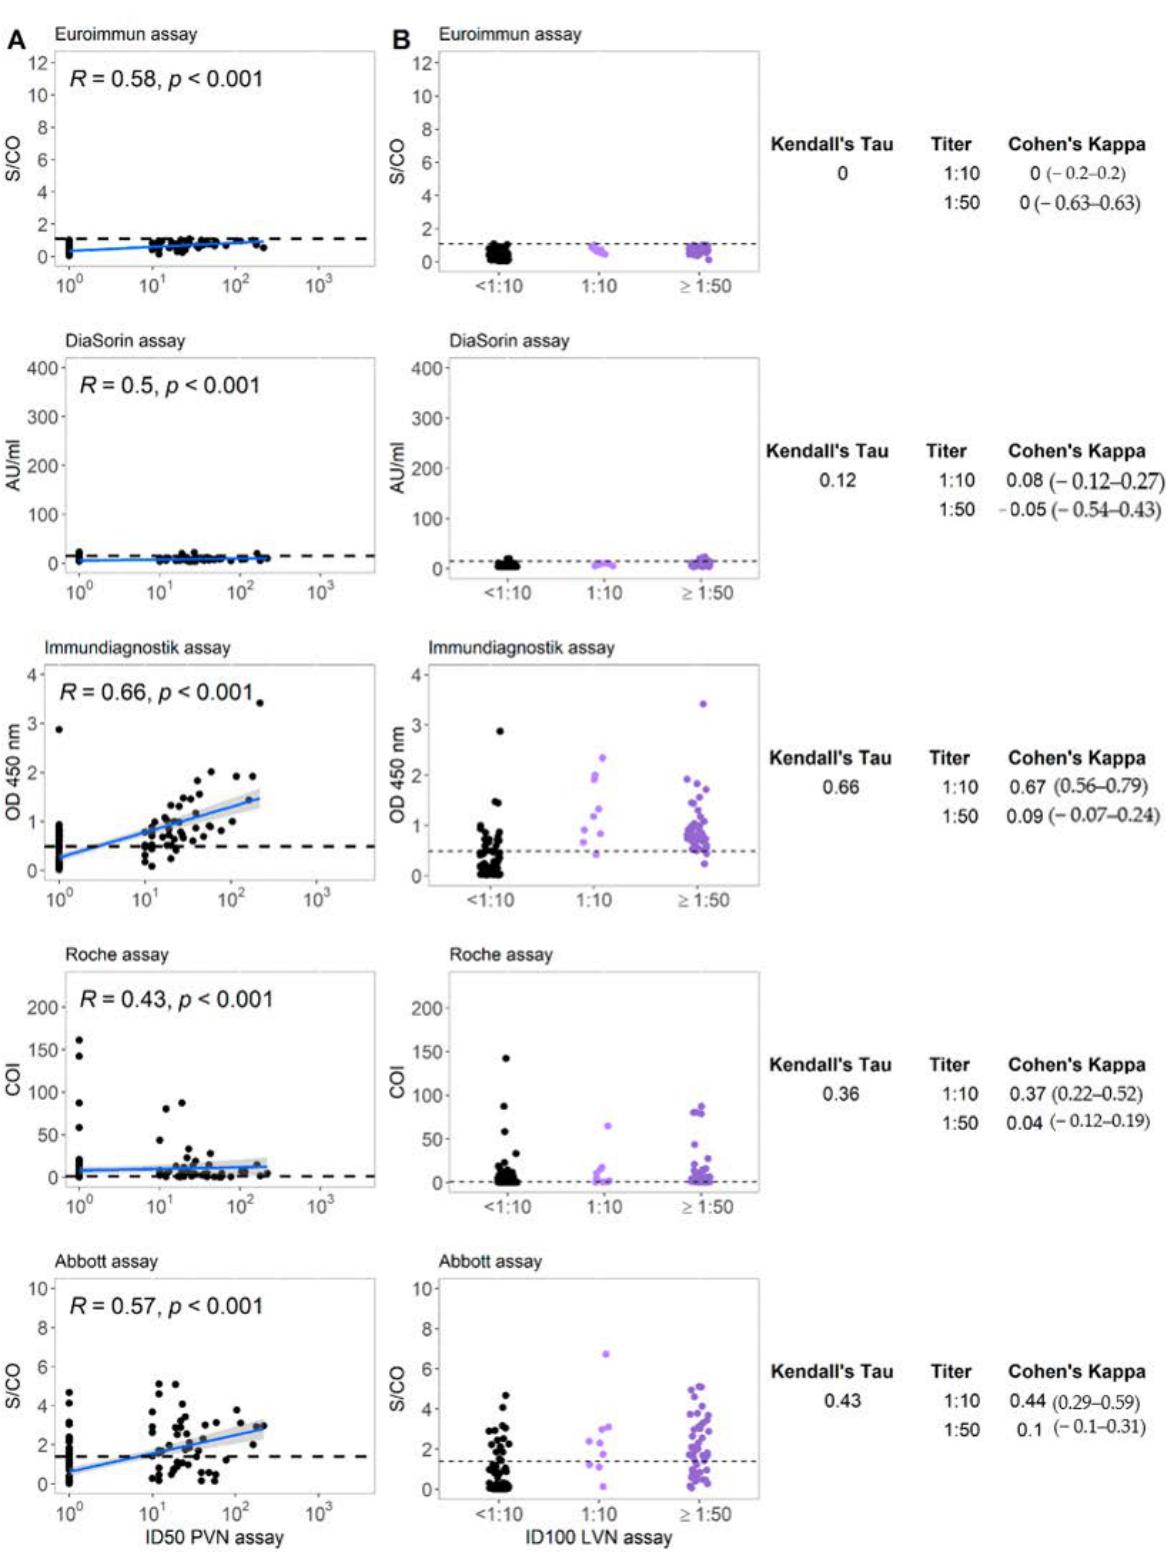
Figure 5. ( A ) Correlation between five commercial anti-SARS-CoV-2 serological assays and the pseudovirus neutralizing antibody titer for group B. R represents the Spearman rank correlation coefficient ρ . ( B ) Correlation between five commercial anti-SARS-CoV-2 serological assays and live virus neutralizing antibody titer for group B. Horizontal lines represent cutoff values for individual commercial tests. Kendall’s τ and Cohen’s κ are displayed for each test combination. LVN, live virus neutralization assay; PVN, pseudovirus neutralization assay; ID100, 100% inhibitory dilution; ID50, 50% inhibitory